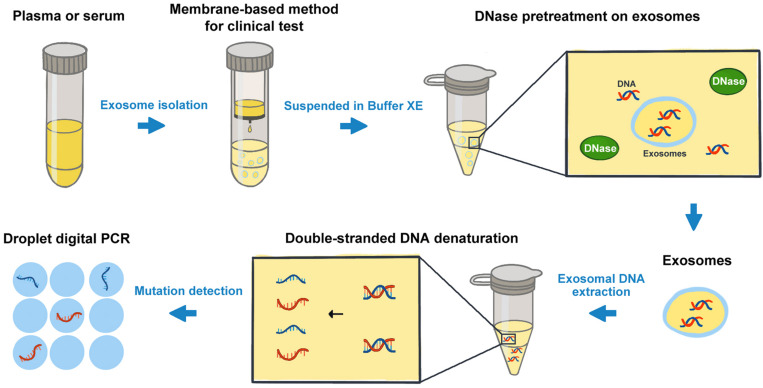
A brief work-flow chart for the mutation detection on exosomal DNA from cancer patients.